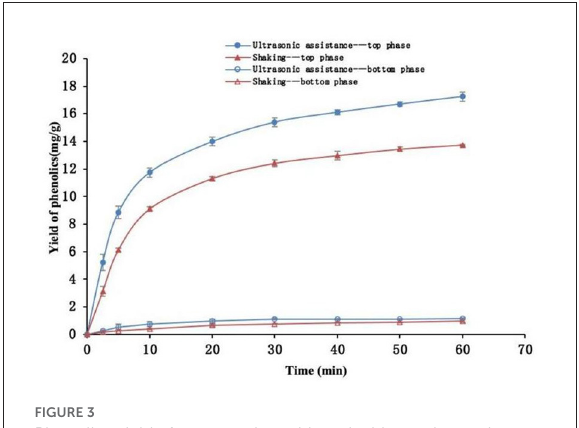
FIGURE3 Phenolics yield after extraction with and without ultrasonic assistance.